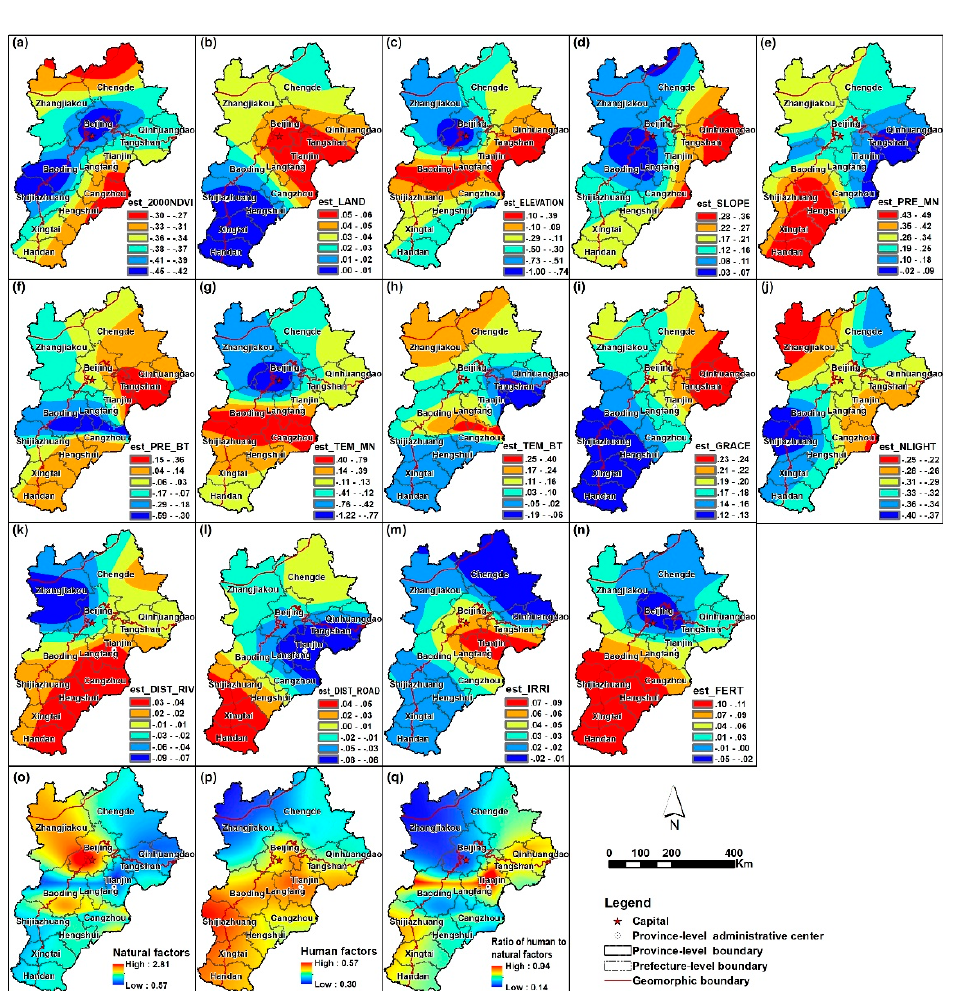
Figure 4. ( a ) GWRec of initial NDVI. ( b ) GWRec of land cover type change. ( c ) GWRec of elevation. ( d ) GWRec of slope. ( e ) GWRec of annual average precipitation. ( f ) GWRec of changes in precipitation during the growing season. ( g ) GWRec of annual average temperature. ( h ) GWRec of changes in temperature during the growing season. ( i ) GWRec of GRACE changes. ( j ) GWRec of NLIGHT changes. ( k ) GWRec of river Euclidean distance. ( l ) GWRec of road Euclidean distance. ( m ) GWRec of irrigation change. ( n ) GWRec of fertilization change. ( o ) Sum of the absolute values of the GWRec of natural factors. ( p ) Sum of the absolute values of the GWRec of human factors, and ( q ) ratio of human to natural factors.